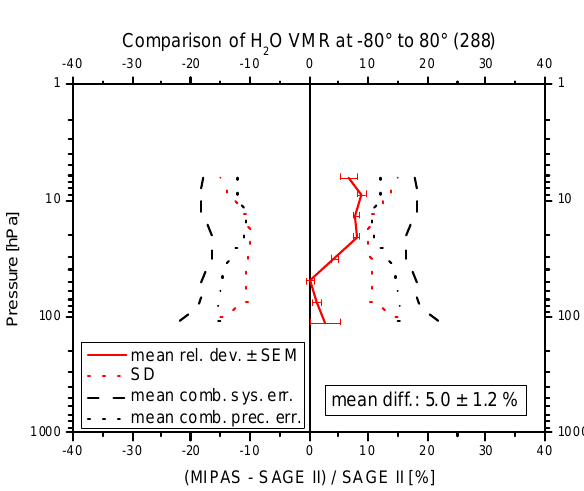
Fig. 16. Mean relative deviation of H 2 O profiles as measured by MIPAS and SAGE II for all collocations (288) between 80 ◦ S and 80 ◦ N. Annotation as per Fig. 13.